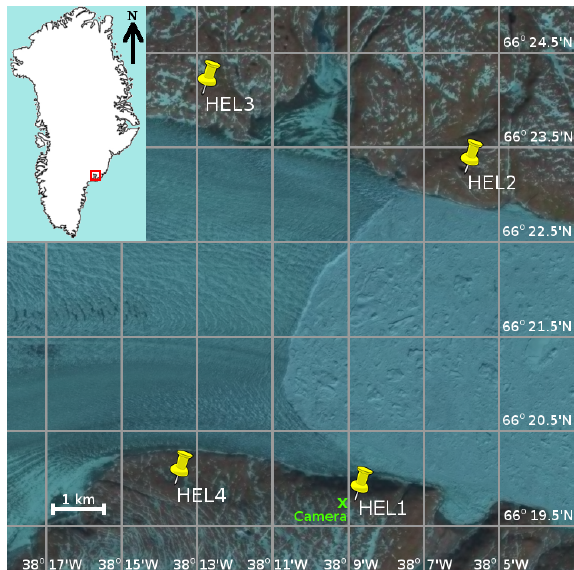
Figure 1. The four bedrock-deployed seismometers deployed at Helheim Glacier as shown on a Landsat-8 image from 9 July 2015. GPS coordinates are referenced to WGS84. HEL1: 66 ◦ 19 . 76 (cid:48) N 38 ◦ 8 . 79 (cid:48) W. HEL2: 66 ◦ 23 . 24 (cid:48) N 38 ◦ 5 . 91 (cid:48) W. HEL3: 66 ◦ 24 . 06 (cid:48) N 38 ◦ 12 . 9 (cid:48) W. HEL4: 66 ◦ 19 . 94 (cid:48) N 38 ◦ 13 . 60 (cid:48) W. The calving front is clearly visible between them. Westward is Helheim Glacier; east- ward is the mélange and Sermilik Fjord. A camera was also set up next to